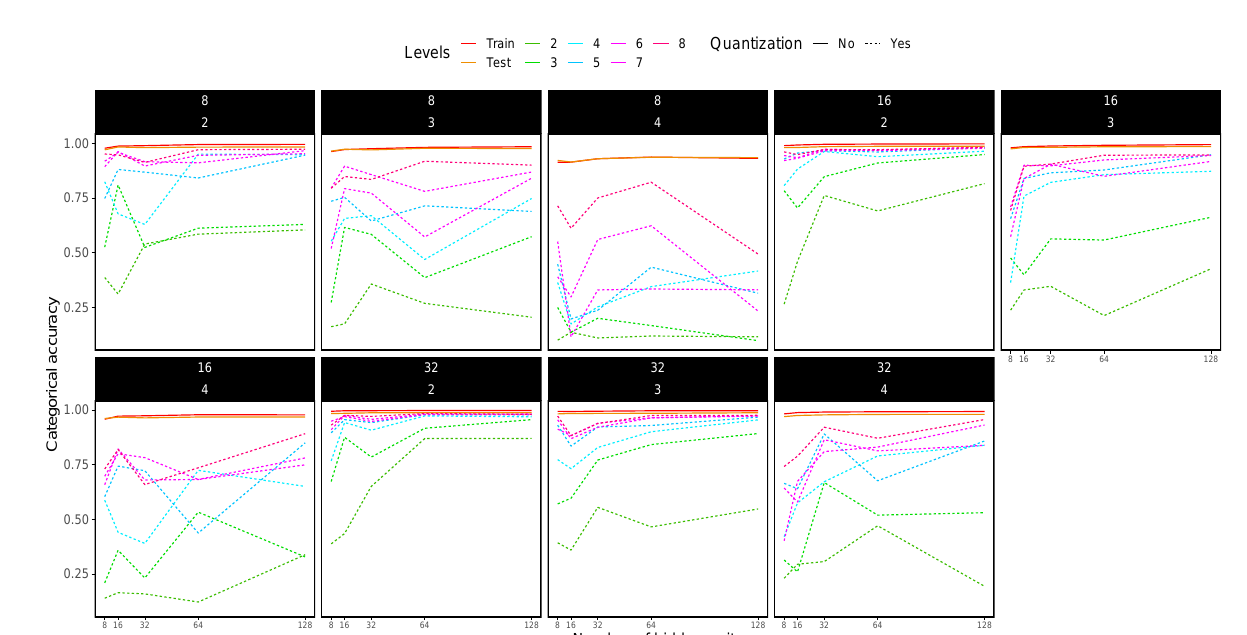
Figure 11. Categorical accuracy for the MNIST dataset using 2-CNN (i.e., one convolutional layer, one intermediate pooling layer, another convolutional layer and a final pooling layer). Only one hidden layer was used, with hidden units ranging from 8 to 128 ( x axis). Each dashed line in the plots shows the accuracy for different quantization levels, while solid lines indicate no quantization. Each box in the figure shows a particular experiment: convolutional layer with 8, 16 and 32 filters (the top number of the box) and pooling with 2 × 2, 3 × 3 and 4 × 4 matrices (the bottom number of the box).